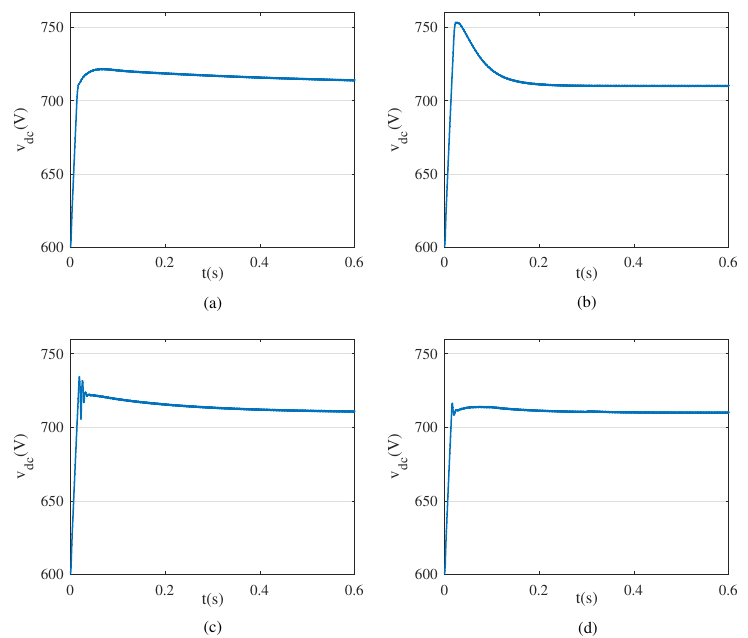
Figure 14. Comparison results between conventional PI controller and fuzzy adaptive PI controller. ( a ) Conventional PI controller with k p = 2.5, k i = 5, ( b ) conventional PI controller with k p = 2.5, k i = 50, ( c ) conventional PI controller with k p = 10, k i = 50, and ( d ) fuzzy adaptive PI